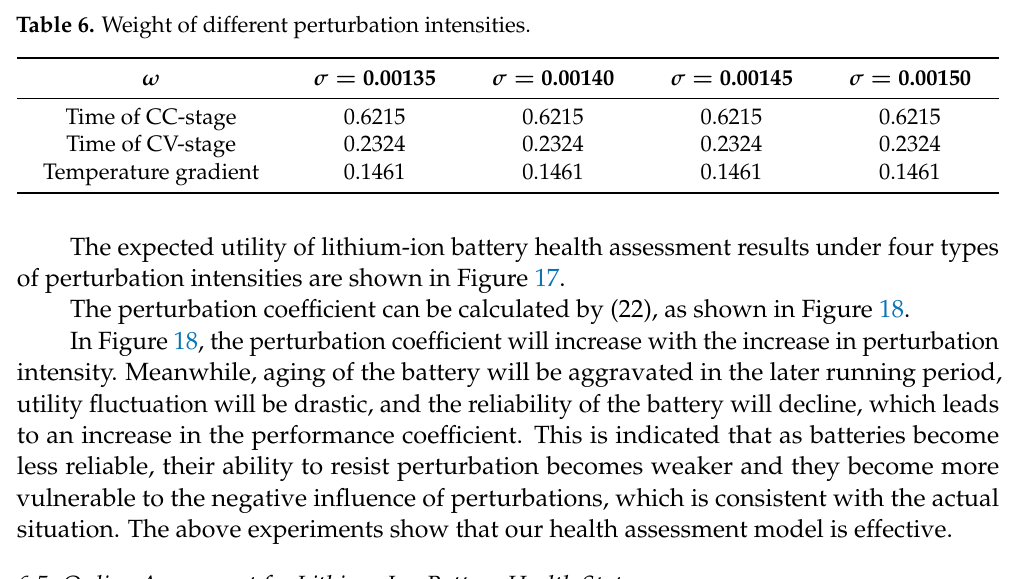
Table 6. Weight of different perturbation intensities.